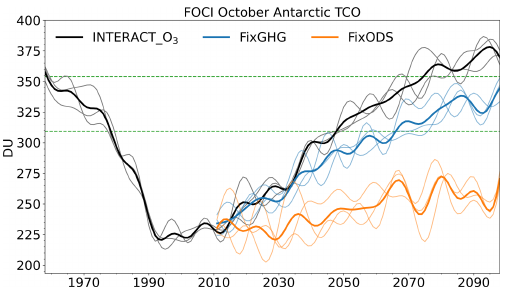
Figure 2. Time series of polar cap (60–90 ◦ S) total column ozone for October (DU) from INTERACT_O 3 in black, FixGHG in blue, and FixODS in orange. The ensemble means are depicted by thick lines and the individual members by thin lines. The dashed horizon- tal green lines mark the 1980 and 1960 ozone levels, computed from the ensemble mean given as the 1979–1981 and 1959–1961 aver- ages, respectively. The time series were filtered using a 10-point boxcar